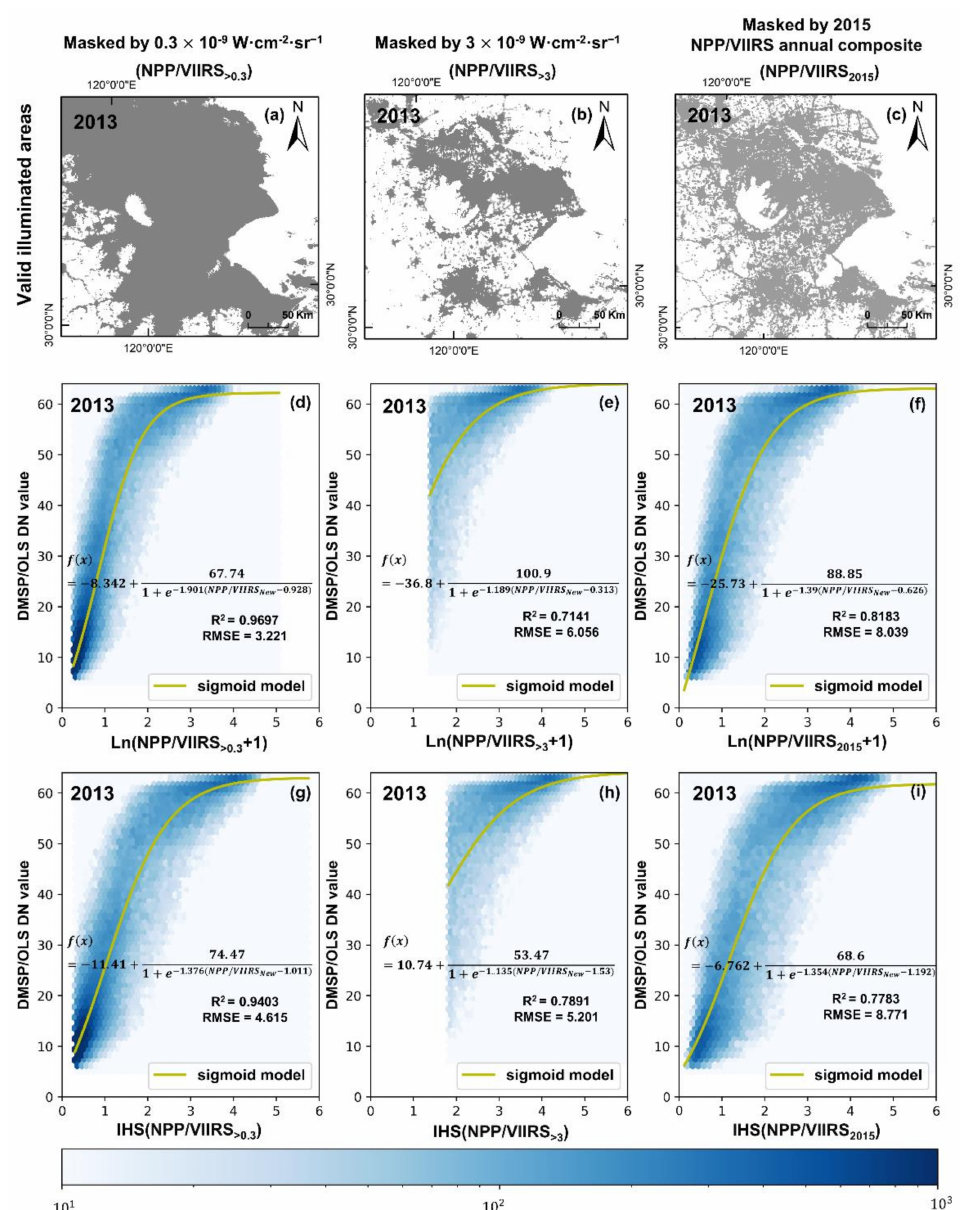
Figure 2. Results from three background noise mask methods for defining the upper/lower limits: ( a ) an absolute lower limit (0.3 × 10 − 9 W · cm − 2 · sr − 1 ) and a relative upper limit (the city core); ( b ) an absolute lower limit (3 × 10 − 9 W · cm − 2 · sr − 1 ) and a relative upper limit (the city core); and ( c ) the limits from the NPP/VIIRS annual composite of 2015. Addition- ally, the corresponding sigmoid regression performance after applying the logarithmic (the middle row, d – f ) and IHS transformation (the bottom row, g – i ) to the masked NPP/VIIRS data in